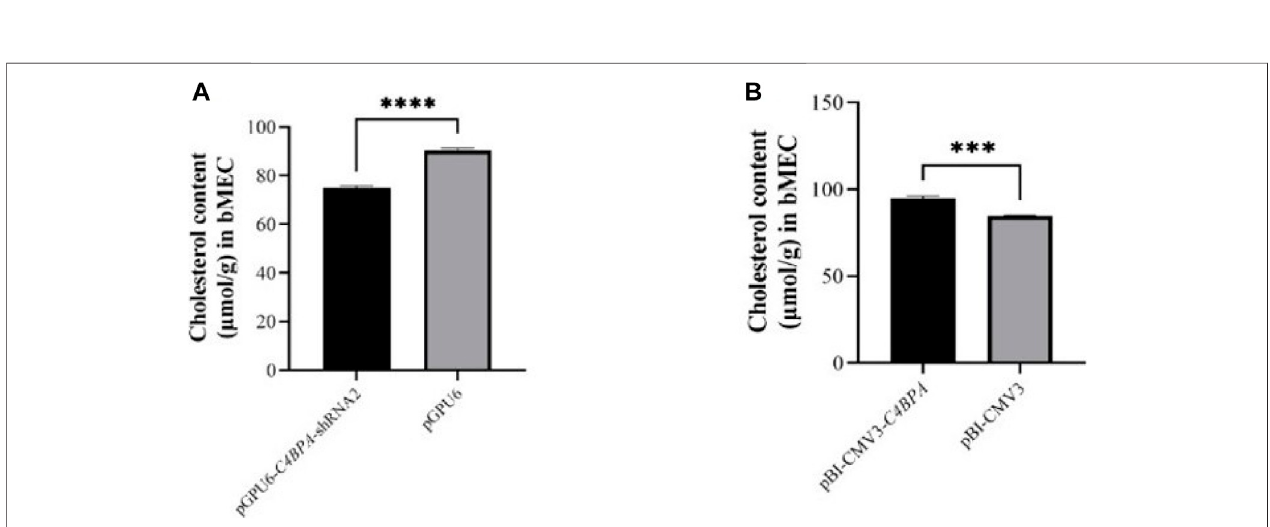
FIGURE9 | (A) The relativecontent of cholesterol inbMECs after transfection with pGPU6- C4BPA -shRNA2. (B) The relative content ofcholesterol in bMECs after transfection with pBI-CMV3- C4BPA .